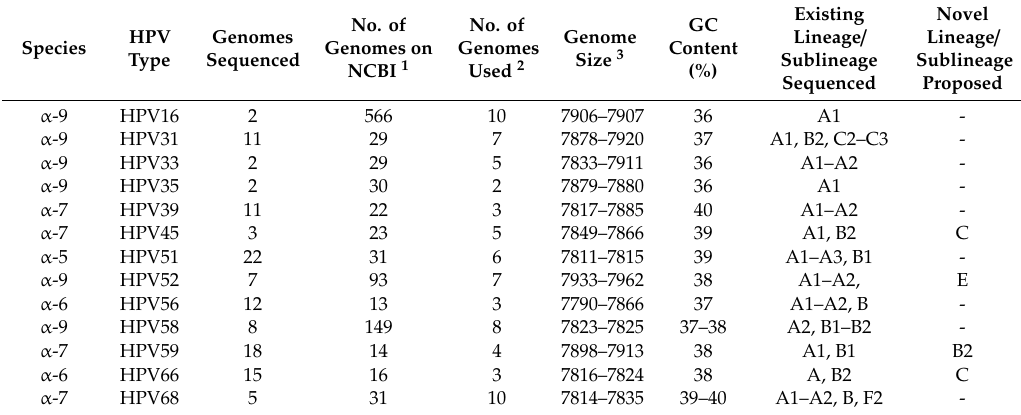
Table 3. Classification of high-risk complete HPV genomes sequenced in our study.